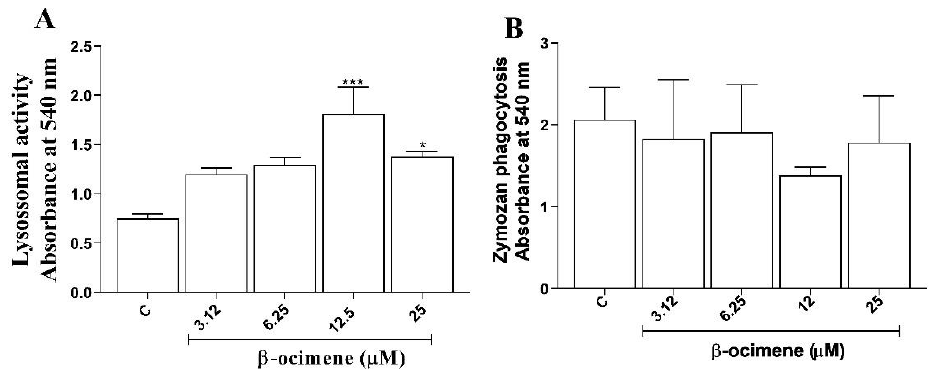
Figure 5. The influence of β -ocimene on the lysosomal volume ( A ) and phagocytic activity ( B ). RAW 267.4 macrophages were treated at a range of concentrations for 72 h. Lysosomal activity was analyzed spectrophotometrically by quantifying the increase in neutral red (NR) uptake following solubilization with the extraction solution. The phagocytosis was analyzed by incorporation of NR-stained zymosan, solubilized with the extraction solution. Data are presented as mean ± S.E.M. of three experiments carried out in triplicate. (*) p < 0.05 vs. control; (***) p < 0.001 vs. control. C — control.